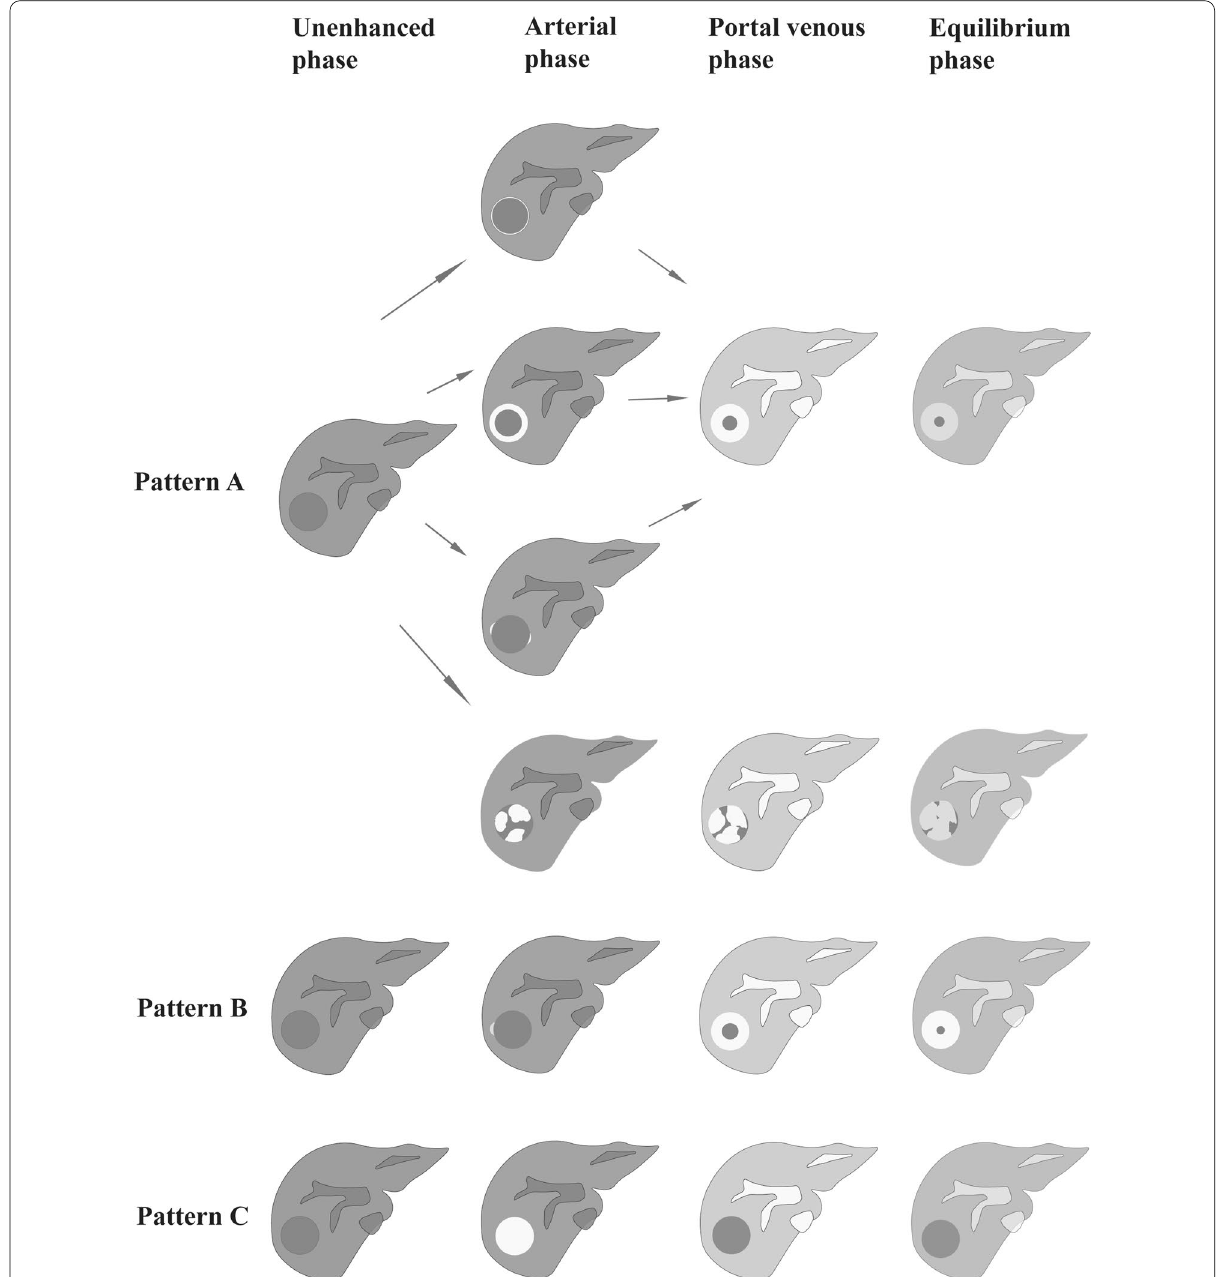
Fig. 6 The three patterns of contrast enhancement on triple-phase CT or MRI scans. Grey nodules represent tumour entities. The white colour represents an enhancement of the tumours, and as the whiteness increases, so does the degree of